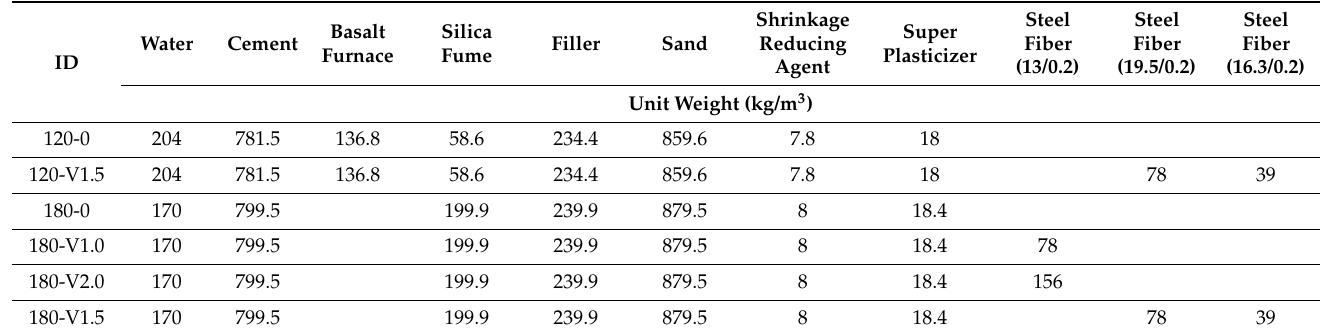
Table 2. Mix proportion of UHPFRCs.